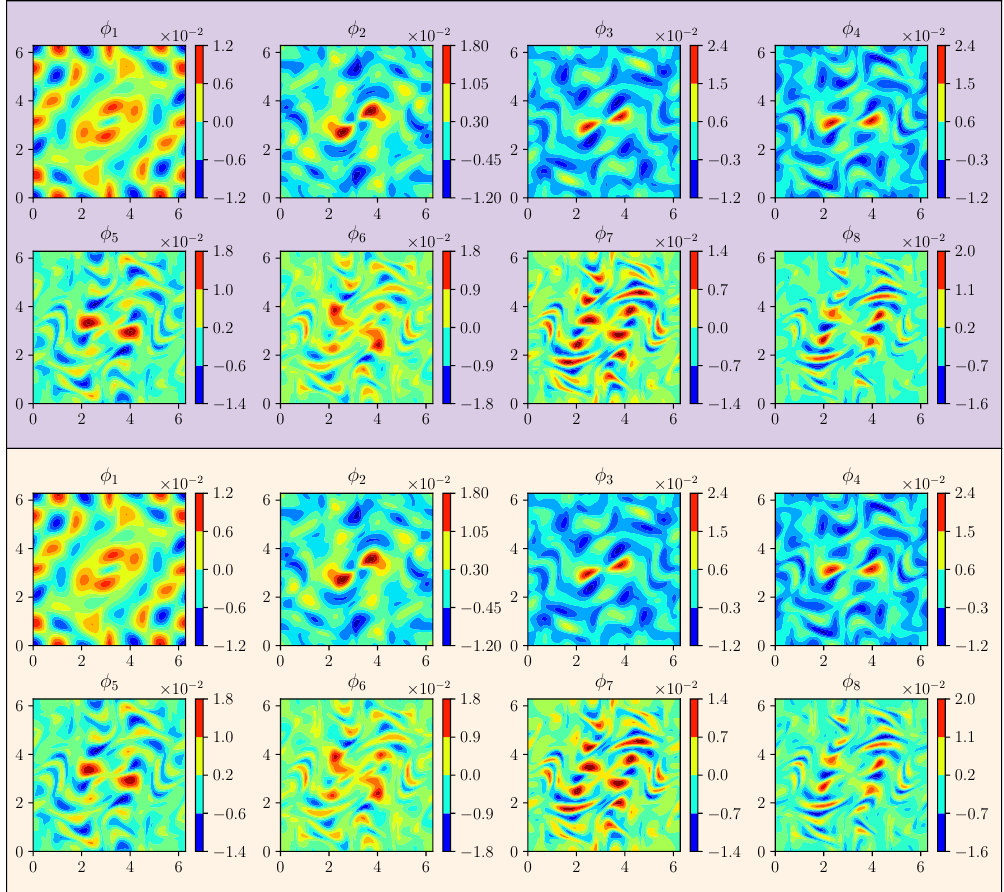
Figure 5. Proper orthogonal decomposition (POD) basis functions for Re = 1000 with γ = 0.1 illustrating the true basis functions generated from the full order model (FOM) data ( top ) and the Grassmann interpolated basis functions generated from the data provided by the training snapshots ( bottom